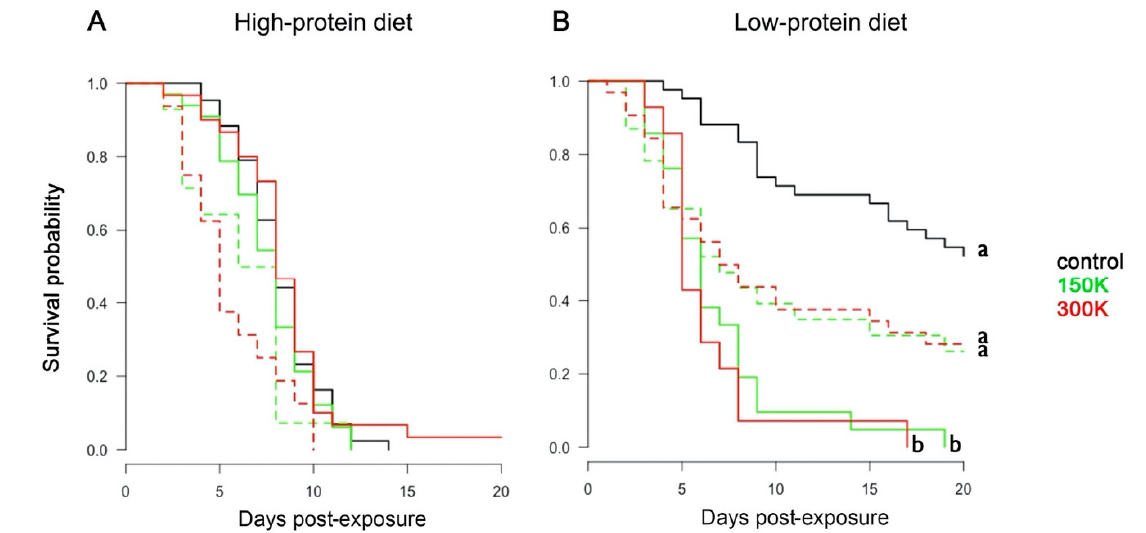
Figure 2. Survival analyses. Survival probability of bumblebees fed the high-protein diet ( A ) and the low-protein diet ( B ) for the different spore dosages (control, 150 K, and 300 K) across time. PCR-positive (dashed lines) and PCR-negative (solid lines) bumblebees are differentiated. Different letters associated with curves indicate statistical differences in survival ( p < 0.05; post hoc Tukey test after Cox regression model in a Kaplan–Meier test curve, see Table S2). Each group contained between 44 and 47 individuals. Table 3. Cox regression model testing the effect of spore dosage on the survival of bumblebees for each diet.